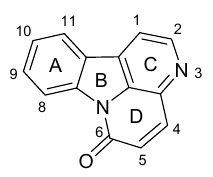
Figure 1. Structure of canthin-6-one.